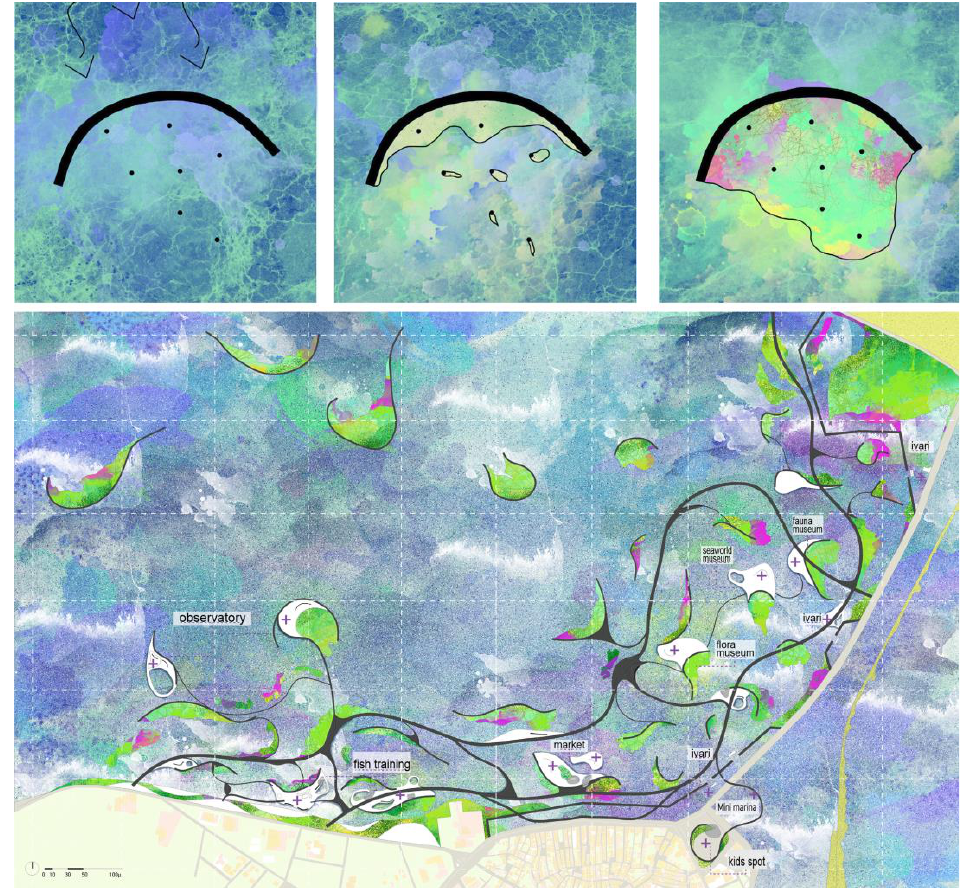
Figure 14. Eleni Kanellopoulou with Karolos Galanos (supervisor), 2022, Urban Safari 38.83, 20.70, Department of Architecture, University of Ioannina. General map proposal. Reproduced with the permission of Kanellopoulou.